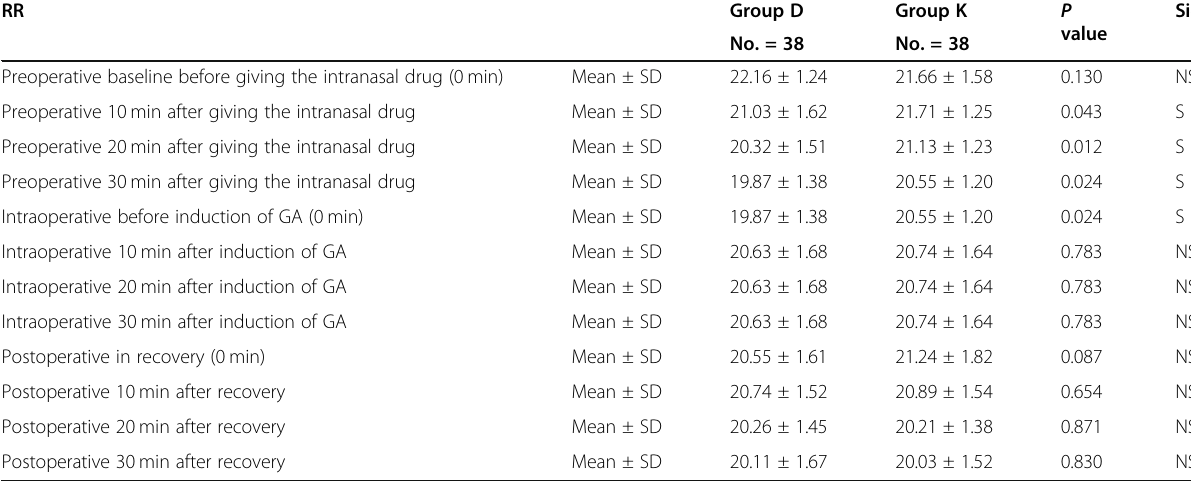
Table 8 Comparison between group D and group K as regards respiratory rate (RR) RR